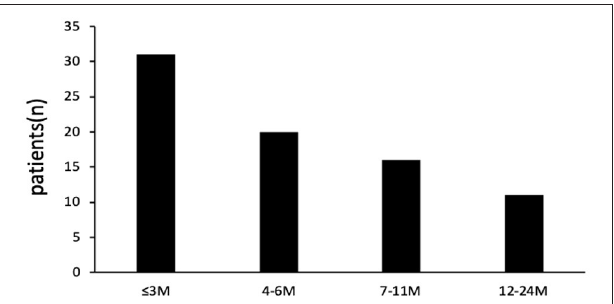
FIGURE 1 | Distribution of B. pertussis infection in infants and young children stratified by age.